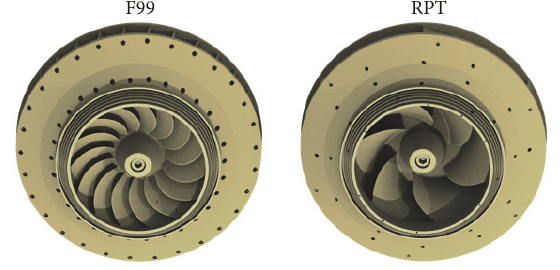
Figure 2: Three-dimensional view of the investigated